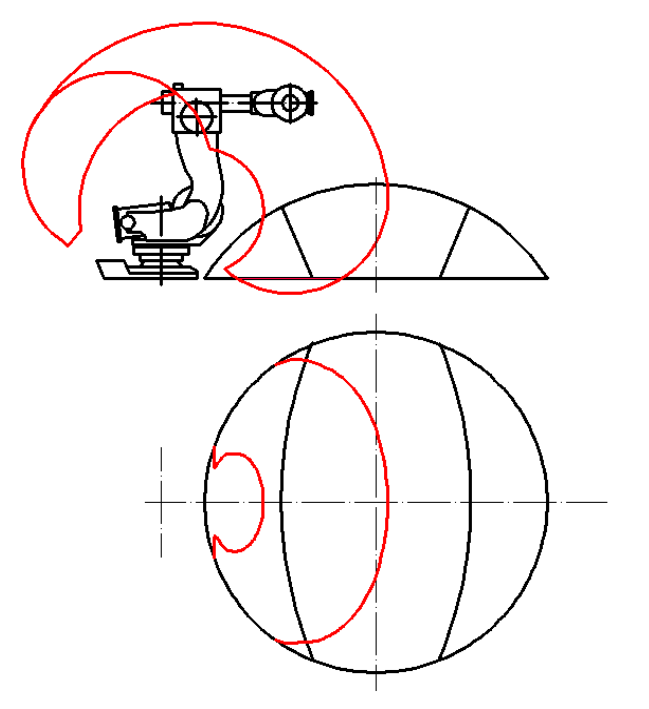
Fig. 7. The location of the seams on the bottom and the working area of the welding robot (in red). On Fig. 7 shows the mutual position of the bottom before welding and the working area of the robot. In the side view, the sloping weld appears to fall entirely into the work area,